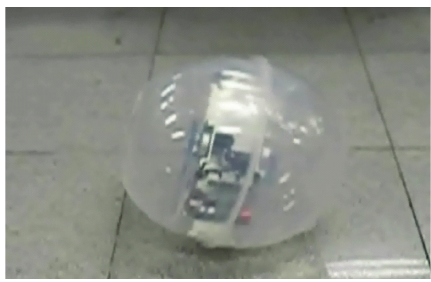
Figure 7: Sphere robot with links.